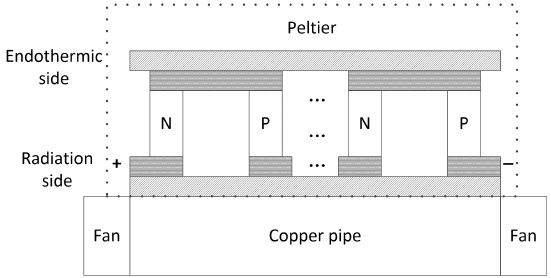
Figure 3. The configuration of the Peltier